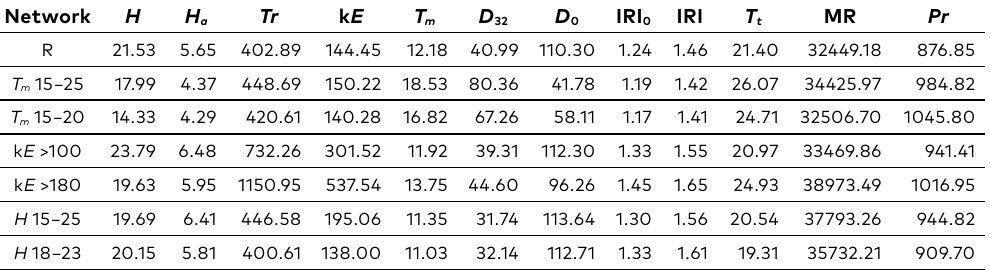
Table 1. Mean value of the parameters included in each network